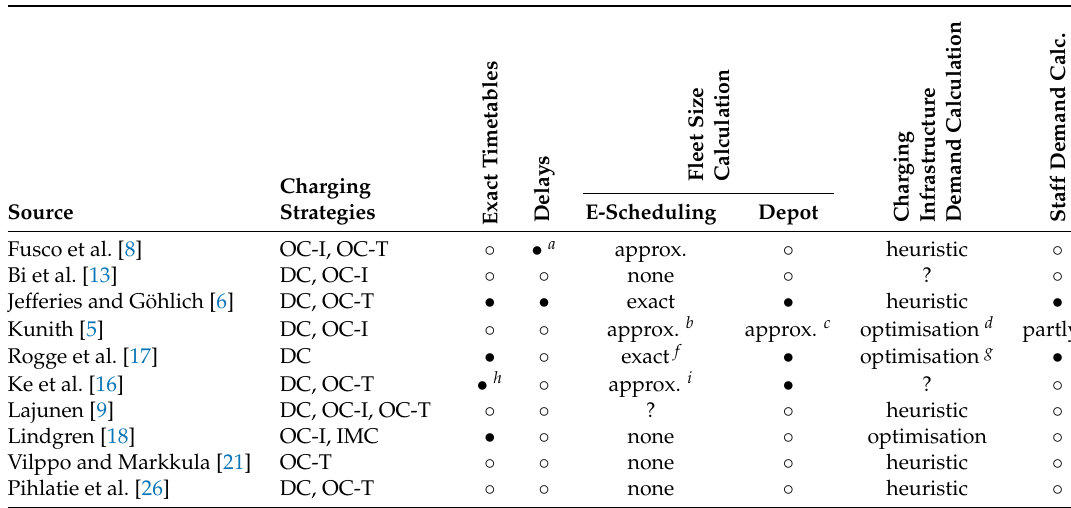
Table 2. Comparison of electric bus system TCO studies. Legend: • yes; ◦ no; – not applicable; ?